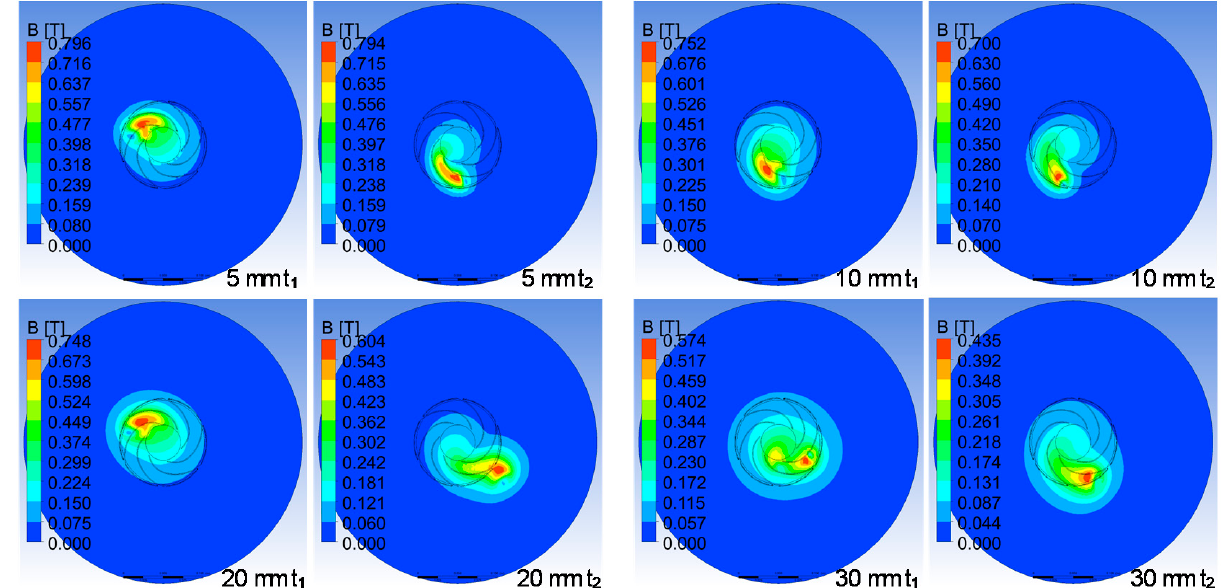
Figure 13. A comparison of magnetic flux density under different gap distances with a range between 5 mm and 30 mm. t 1 and t 2 respectively represents the time of peak current and 28 µ s.